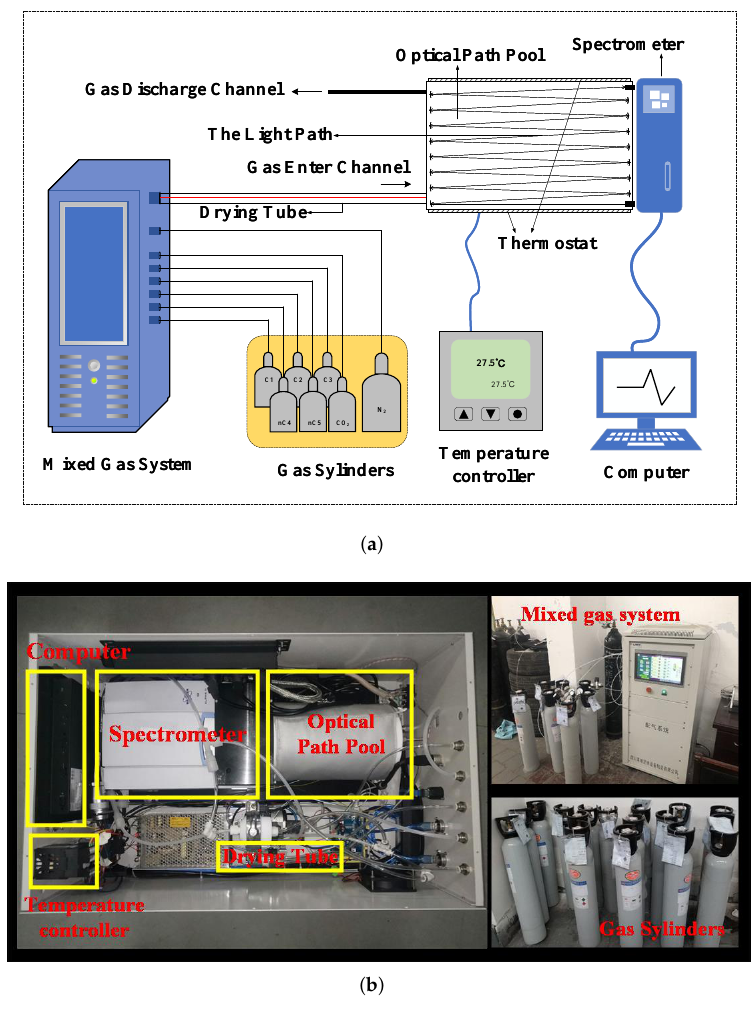
Figure 3. IR spectrum acquisition system. ( a ) Schematic diagram of collection process. ( b ) The actual hardware structure of gas-logging instrument.